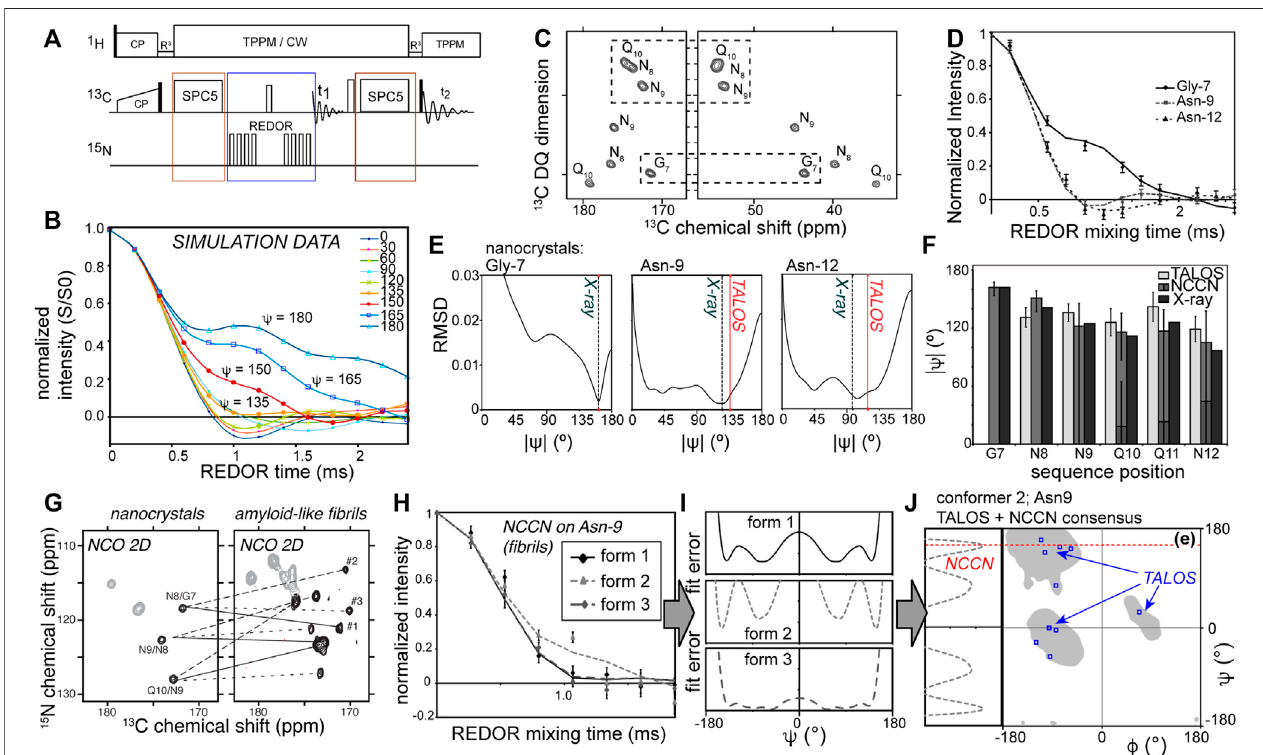
FIGURE 2 | Measuring backbone angle ψ via NCCN experiments. (A) Pulse sequence for a 2D NCCN experiment, in which 2D 13 C- 13 C (SQ-DQ) spectra are acquired for varying lengths of 13 C- 15 N dipolar mixing times. (B) Simulated NCCN dephasing curves, showing the S/S0 intensity ratios as a function of the REDOR mix time. (C) Example 2D SQ-DQ spectrum acquired as part of a NCCN measurement of amyloid-like peptide nanocrystals, along with (D) experimental NCCN curves for three residues. (E) RMSD fi t results of the experimental data, showing the minima. The X-ray and TALOS results are marked as well. (F) Bar graph of the NCCN best- fi t results compared to the TALOS chemical shift analysis and the known X-ray structure data. The NCCN data match the X-ray data, with a better accuracy than TALOS analysis alone. (G) 2D NCO spectra for nanocrystalline and fi brillar GNNQQNY peptide (uniformly 13 C, 15 N-labeled in the fi rst four residues, marked as residues G7 through Q10 of the parent Sup35p protein). Lines show how each residue gives one signal in the crystals, but three peaks in the fi brils, which complicates distance measurements. (H) A NCCN experiment results probing the backbone angle ψ for Asn-9 in the three co-existing fi bril conformers. Two conformers have similar dephasing curves, but conformer #2 diverges. (I) RMSD curves between simulation and experiment for the full range of ψ angles, for each conformer. Note that the minima occur at multiple angles, and sometimes are broad, providing ambiguous constraints. (J) To resolve this one can combine chemical shift analysis (TALOS) with the NCCN constraints. In this example the 10 best TALOS “ solutions ” are not self-consistent, but by considering the NCCN angle, we pinpoint the optimal result in the β -sheet region near ψ (cid:1) 150 ° . Panels C-J are reprinted with permission from ref. (van der Wel et al., 2010) copyright 2010 American Chemical Society.